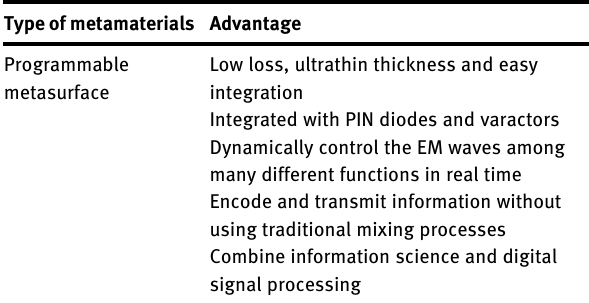
Table  : The advantages of metamaterials for WIT. Type of metamaterials Advantage